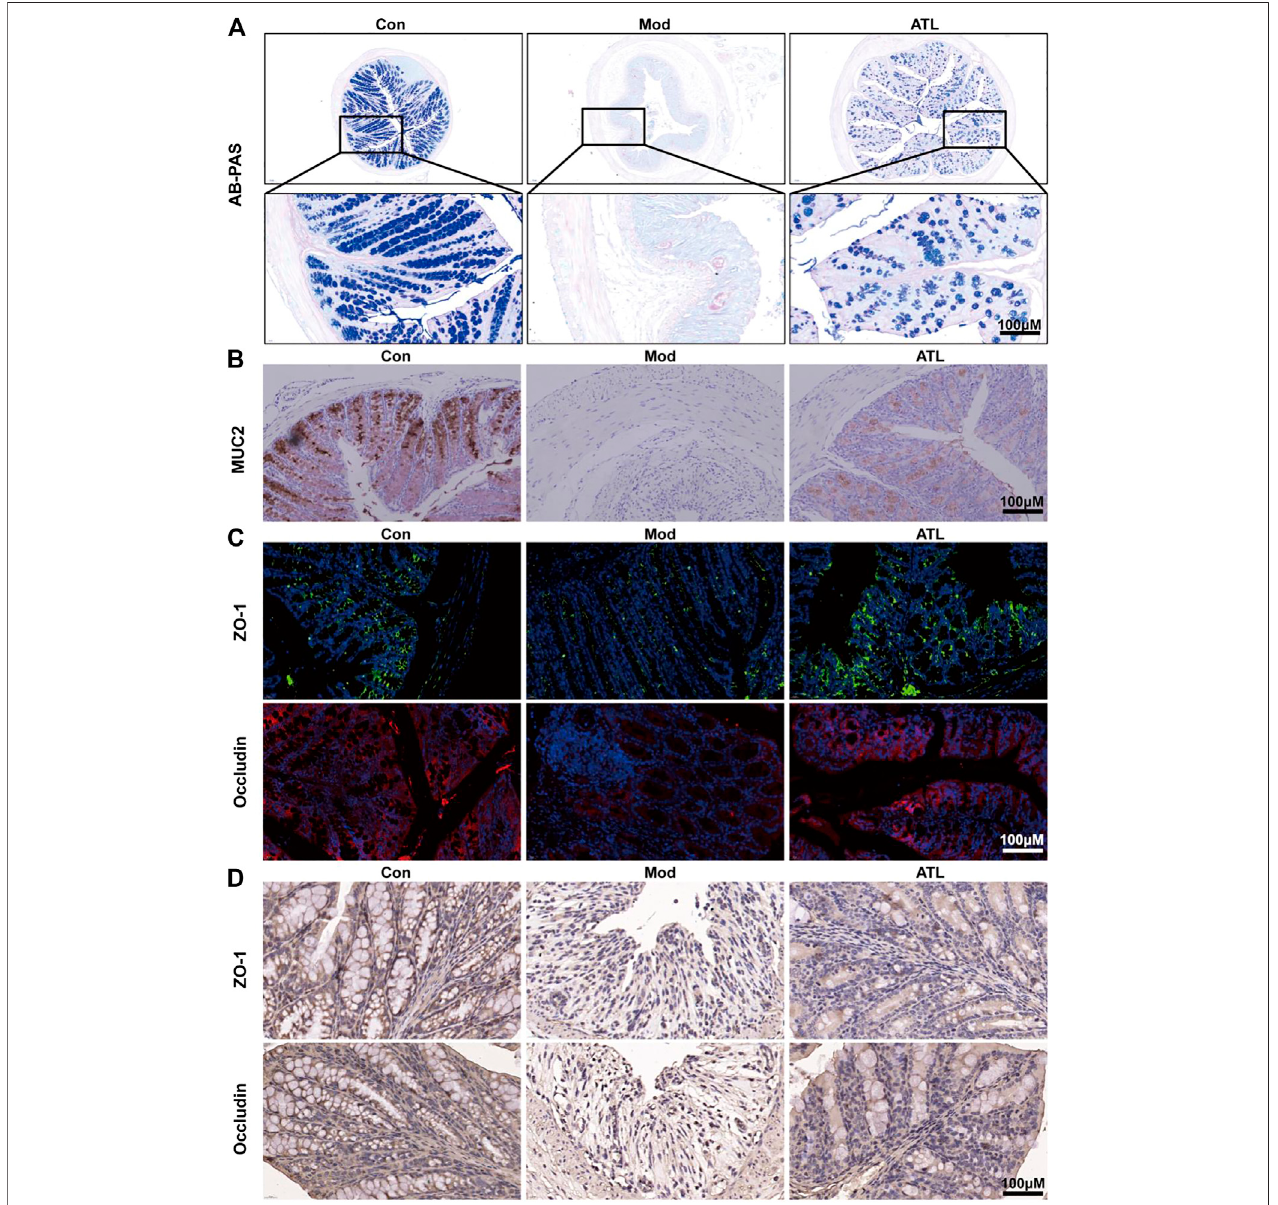
FIGURE 2 | ATL attenuates intestinal barrier of DSS-induced colitis in mice (A) Representative Alcian Blue-Periodic Acid Schiff (AB-PAS) images of colon sections (B) Representative immunostaining images of colon sections stained for Mucin-2 (MUC2) (C) Protein expression of zona occludens-1 (ZO-1) and occludin from colon tissue (D) Representative immunostaining images of colon sections stained for ZO-1 and occludin.